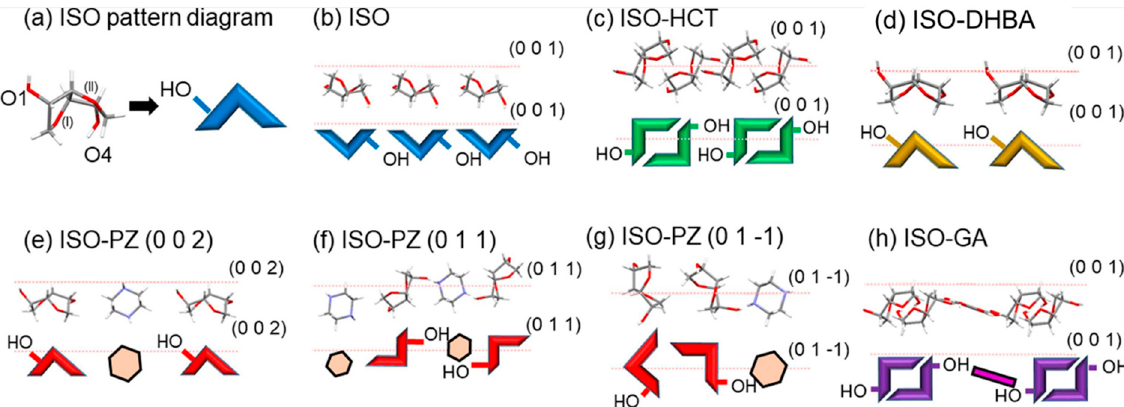
Figure 3. Schematics of the major surface structures of the ISO crystals and co-crystals. Pink dotted lines representing the major crystal faces are shown to indicate the faces that were horizontal and perpendicular to the paper sheet. The crystal face structures are shown with the stick models. Reprinted with permission from [8].